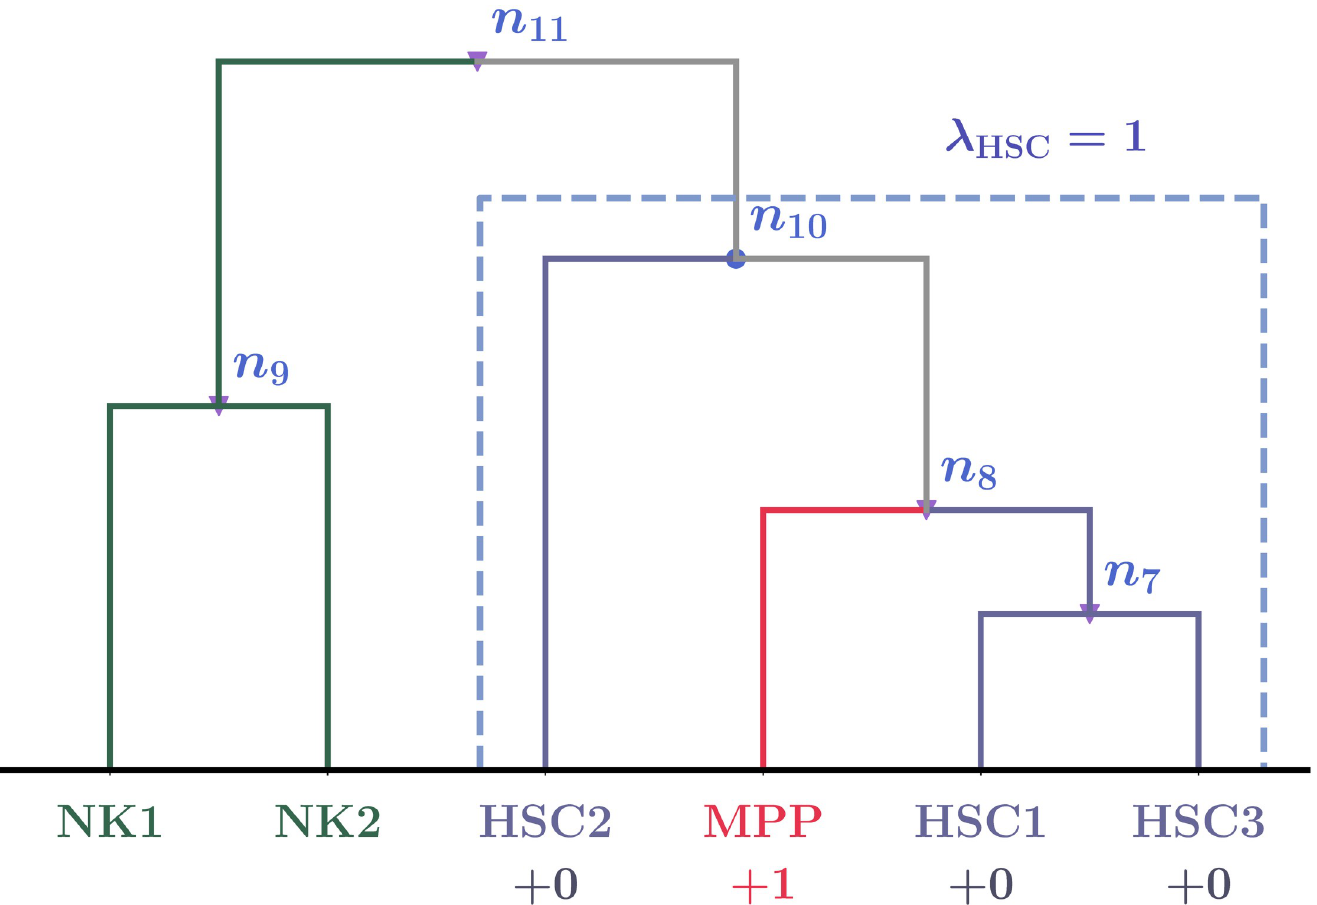
Fig 7. Schema of penalty score calculation. Note that this dendrogram is constructed by artificial data to explain how to calculate the penalty, though we use the same labels such as HSC1. This dendrogram has six leaves, and three of them are classified to type HSC. To explain details of this dendrogram, we freely use the symbols and definitions in Materials and methods in this caption. We can see that τ (HSC) = 10. The corresponding node is n 10 (displayed by the blue dot), and the corresponding cluster C is the set {HSC1, HSC2, HSC3, MPP} (surrounded by the blue dashed line). Among the elements of C 10 others are. Hence, the type penalty of HSC in this figure is computed as λ HSC = 4 − 3 = 1.